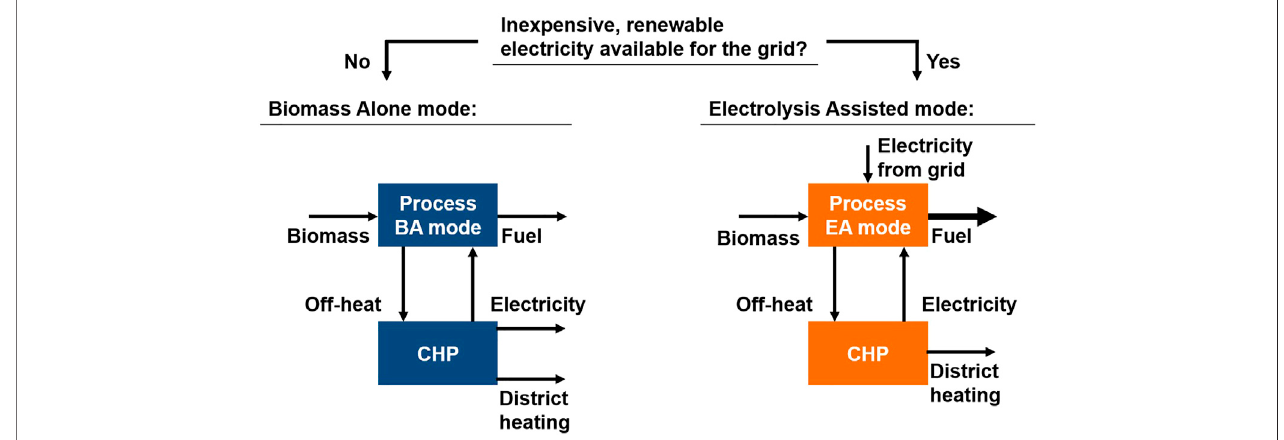
FIGURE 1 | Operation modes for the hybrid process